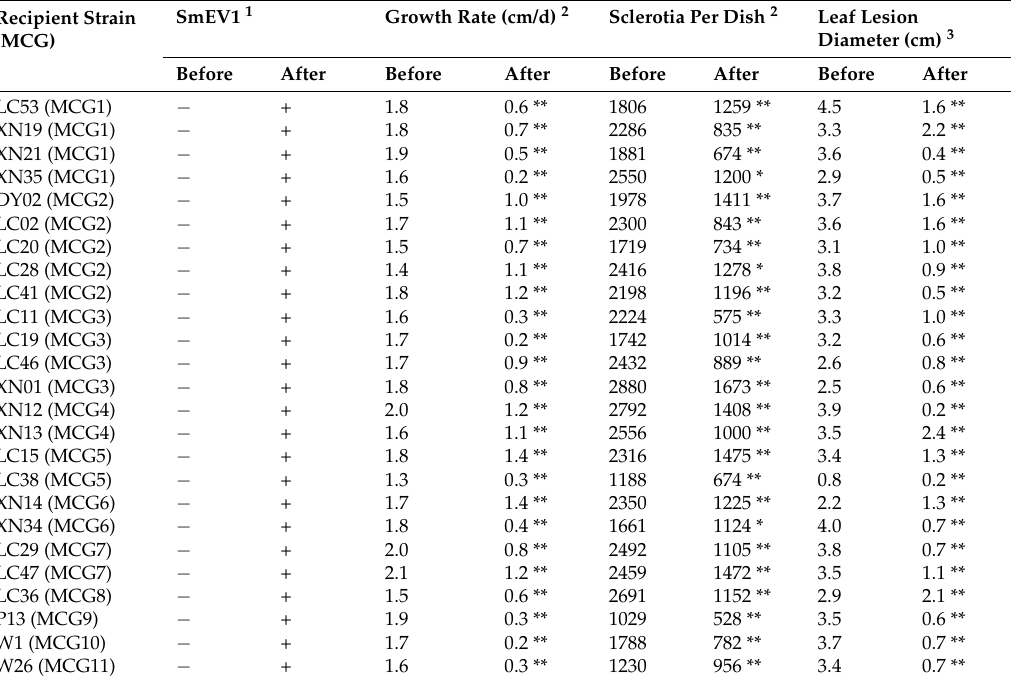
Table 1. Endornavirus SmEV1 transmission from the donor strain LC22 (MCG 5) to other strains of Sclerotinia minor (MCGs 1 to MCG 11), and effect of SmEV1 introduction on mycelial growth, sclerotial yield, and pathogenicity of the